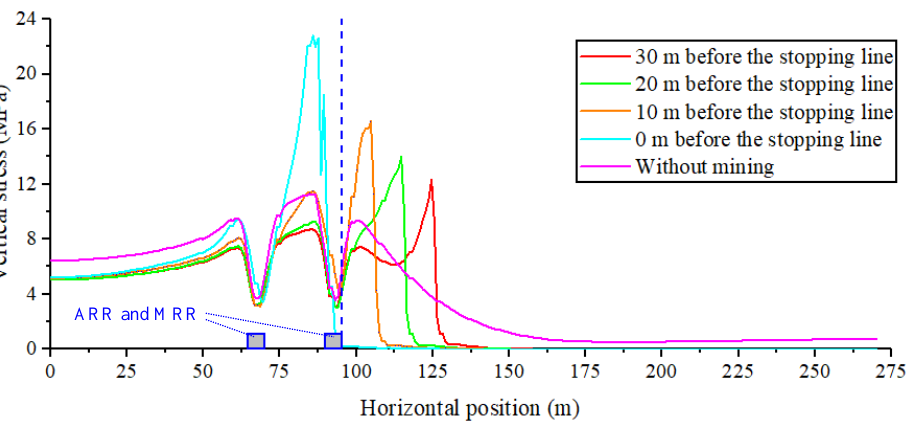
Figure 9. Distribution of immediate roof stress during the final mining period of working face 31,106.